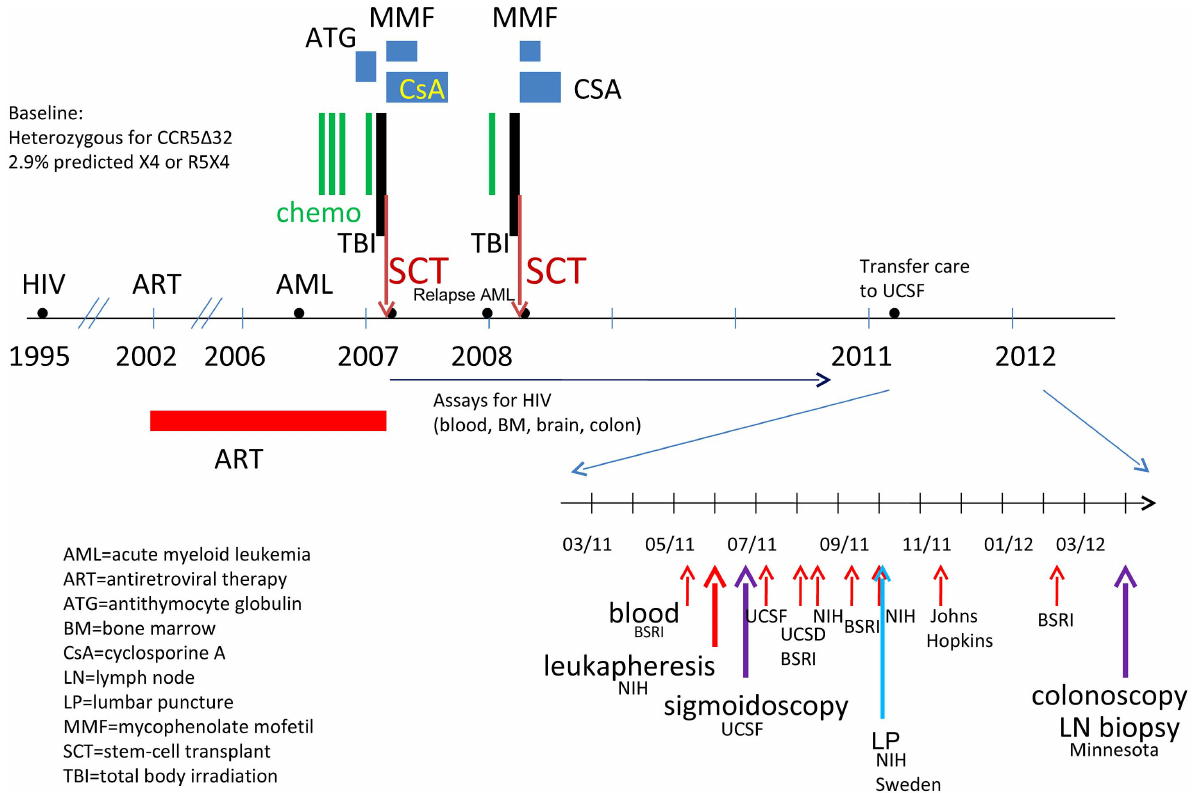
Figure 1. Timeline for clinical treatments and study samples.